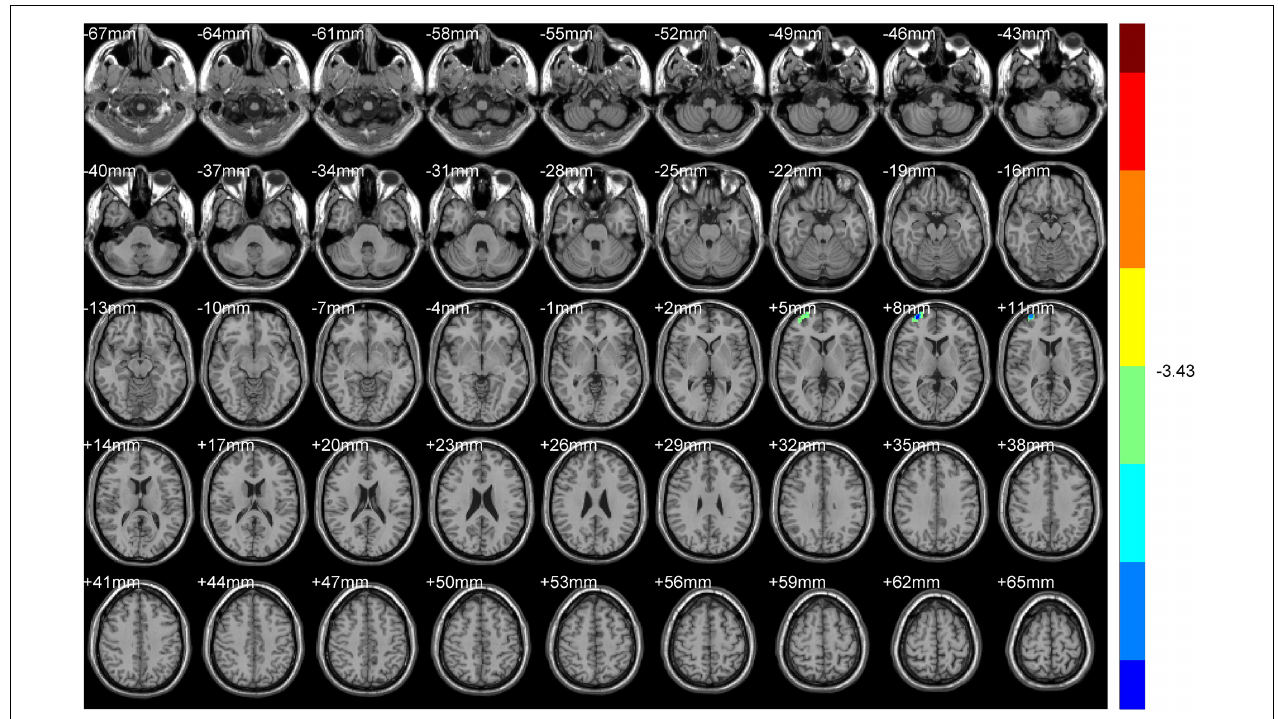
FIGURE 7 | ReHo (Dominant hemisphere vs. Non-dominant